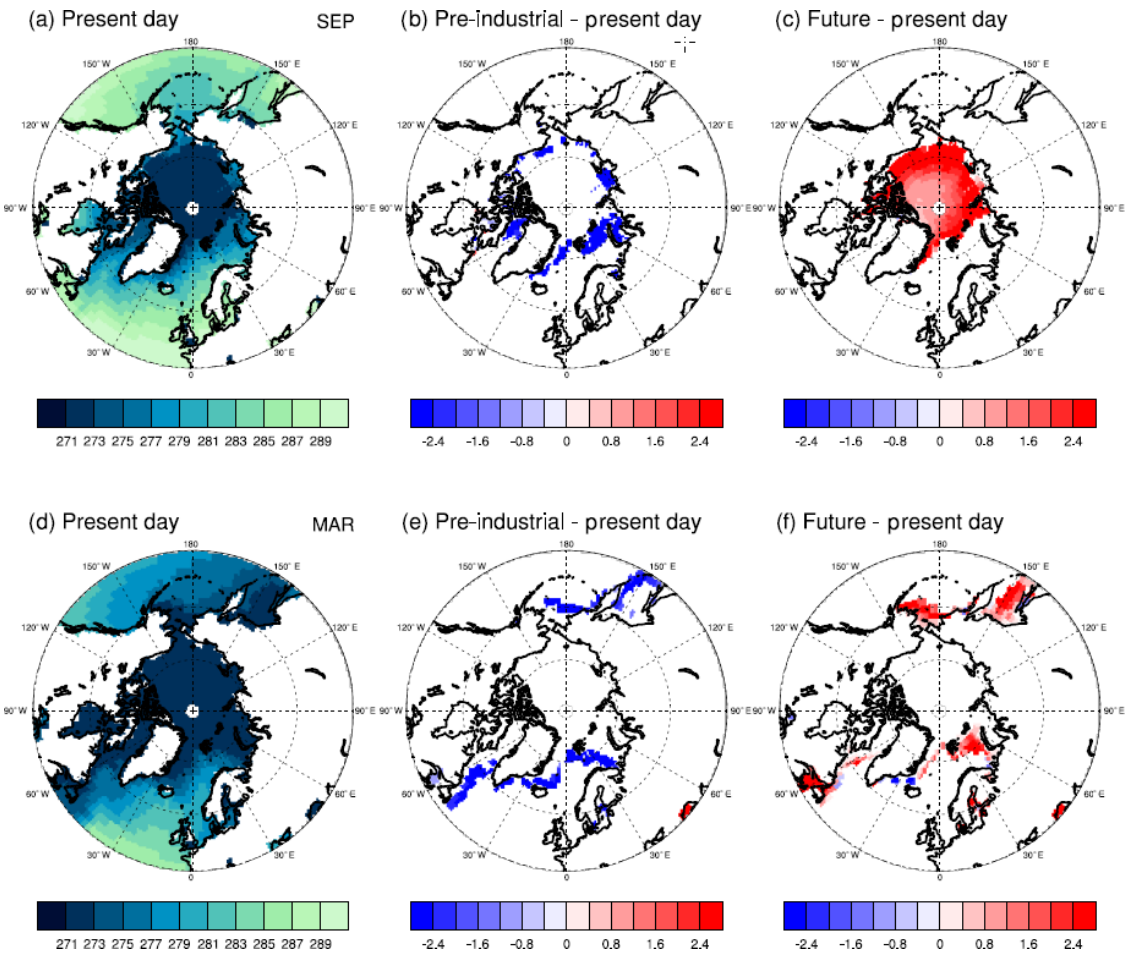
Figure 6. Arctic SST forcing fields. Present-day Arctic SST for (a) September and (d) March. Differences from present-day fields are shown for (b, e) pre-industrial and (c, f) future